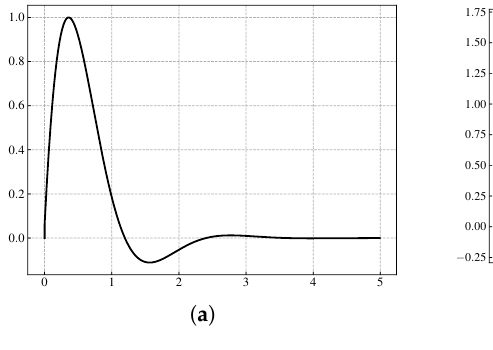
Figure 2. Generated Signal based on CPG by parameters T u = 3.10412, T v = 0.424391, s 0 = 9.28835, b = 9.31659, w fe = 2.99902. The signal decays to zero over time in the time domain. The phase − portrait trajectory stays in one area as a whole denotes that the generated signal is stable. ( a ) The generated signal in the time domain. ( b ) Phase portrait of the generated signal. ( c ) Difference between state variables of the phase